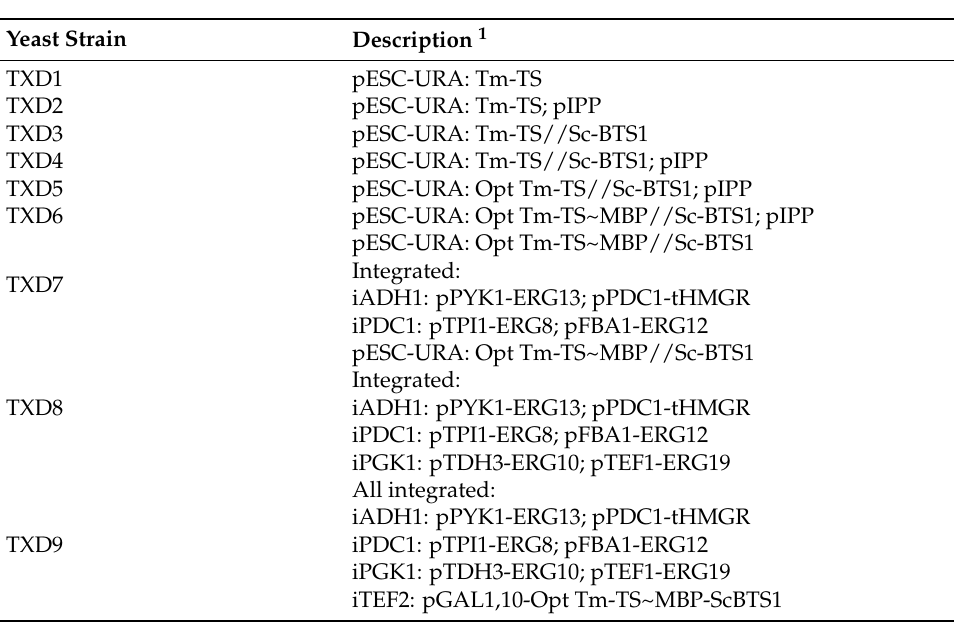
Figure 5. GC-MS analysis: ( A ) selected ion chromatogram and ( B ) their respective mass spectra of taxadiene standard and hexane extract from recombinant yeast (retention time 13.1 min). Table 1. Yeast strains built in this study.